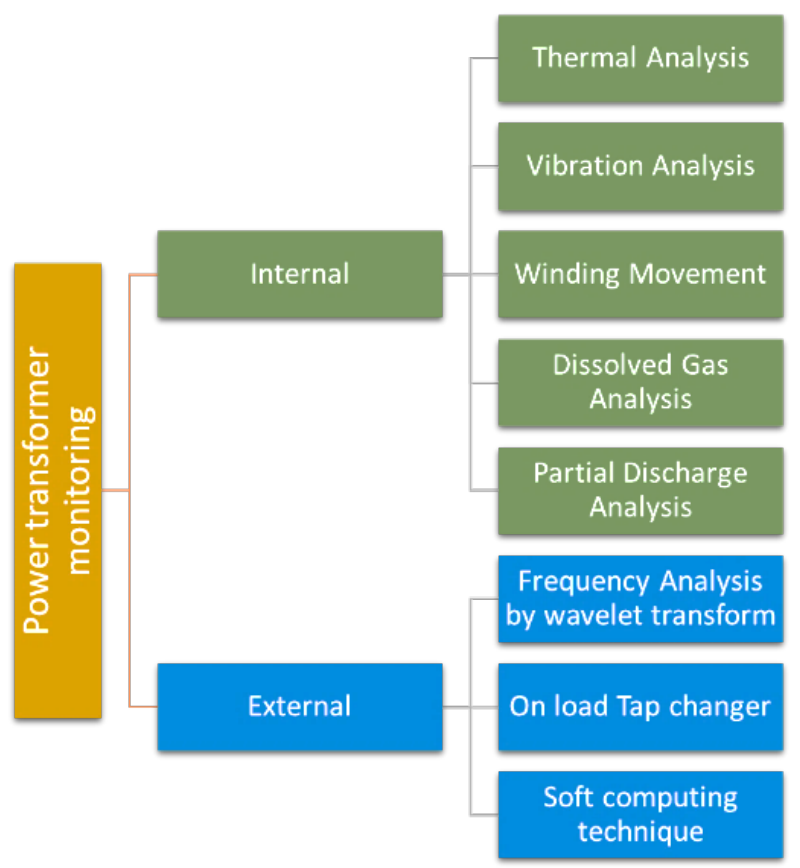
Figure 5. Power transformer monitoring techniques .